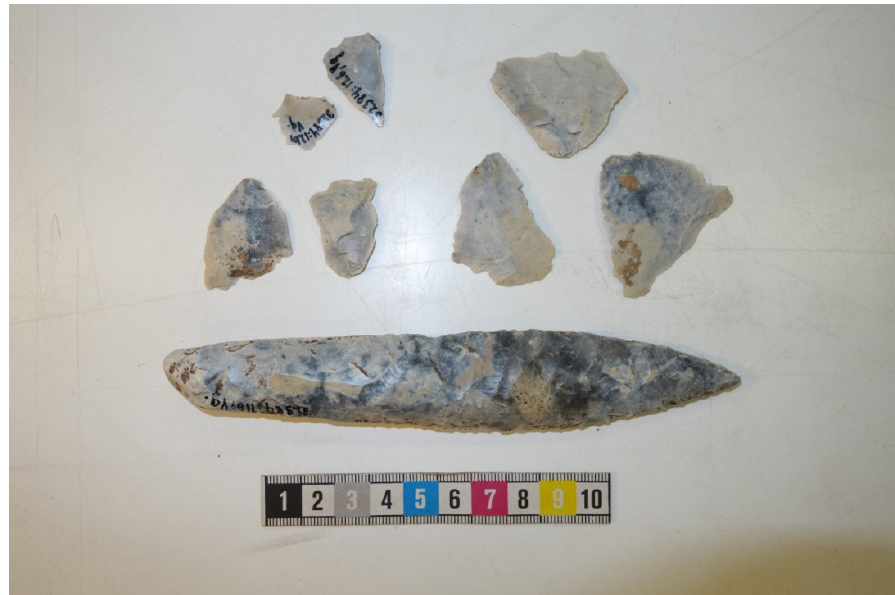
Figure 16. Flint dagger and flint flakes from Falköping stad 5. Photo by Malou Blank, CC